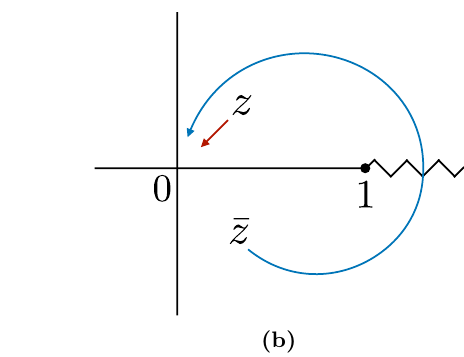
and x 2 are held fixed and spacelike. The 12 34